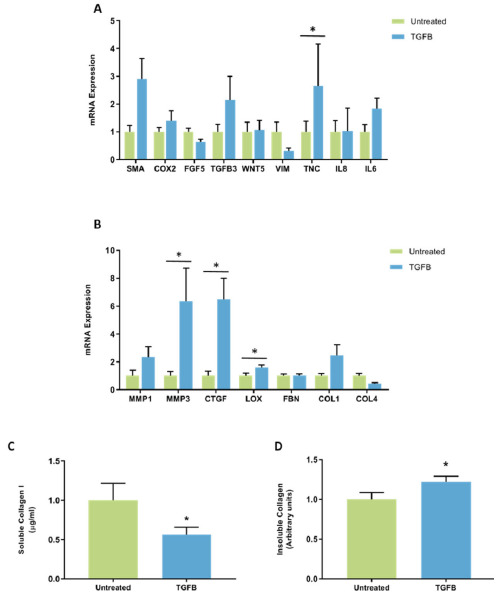
Figure 8. The effect of TGFB on mRNA expression and collagen production in mammary fibroblasts. Messenger RNA expression of cancer-associated genes ( A ) and genes involved in extracellular matrix regulation and collagen production ( B ) measured by RT-PCR in human mammary fibroblasts following treatment with 10 ng/mL of TGFB for 72 h. mRNA expression normalised to HPRT1 expression and presented as relative expression where the average for untreated control is 1. Collagen production was measured using collagen 1 ELISA ( C ) and insoluble collagen measured by sirius red staining ( D ). Data presented as mean + SEM with statistical analysis performed using a linear mixed- effects model Tukey’s post hoc comparison. Statistical significance indicated by * when p <